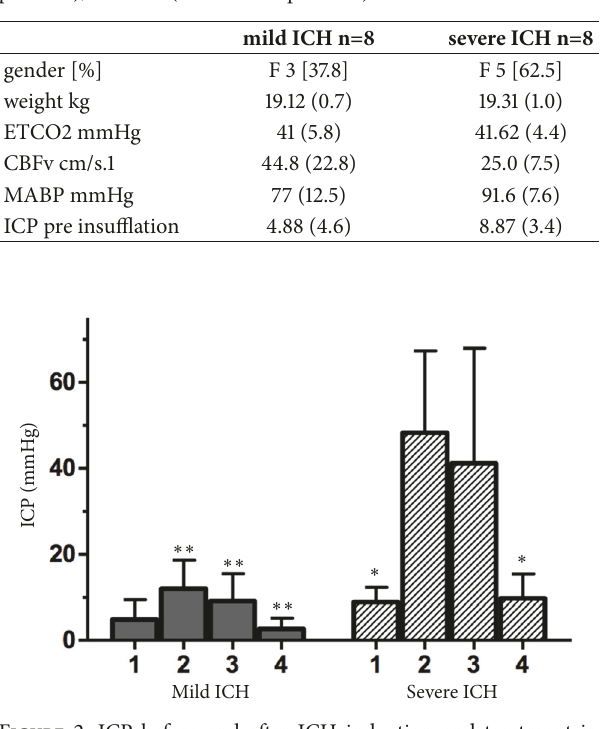
Figure 2: ICP before and after ICH induction and treatment in the mild and severe ICH groups ( ∗∗ p < 0.03 for the comparison with ICH and ∗ p < 0.001 for the comparison with balloon inflation). ICP (intracranial pressure) and ICH (intracranial hypertension); 1 (basal), 2 (balloon inflation), 3 (saline solution infusion), and 4 (balloon